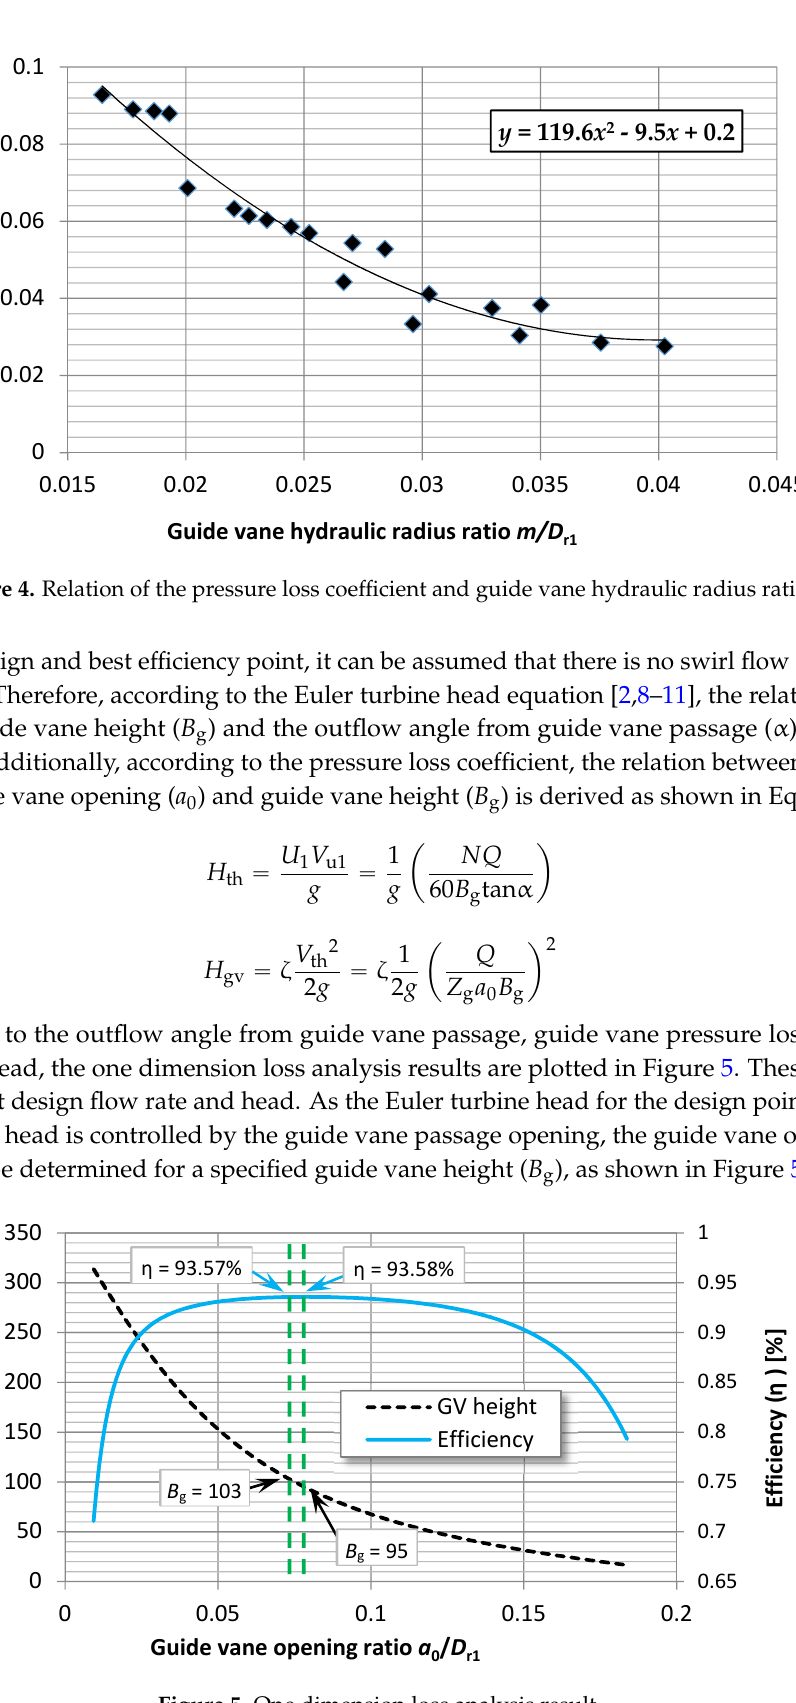
Figure 5. One dimension loss analysis result.